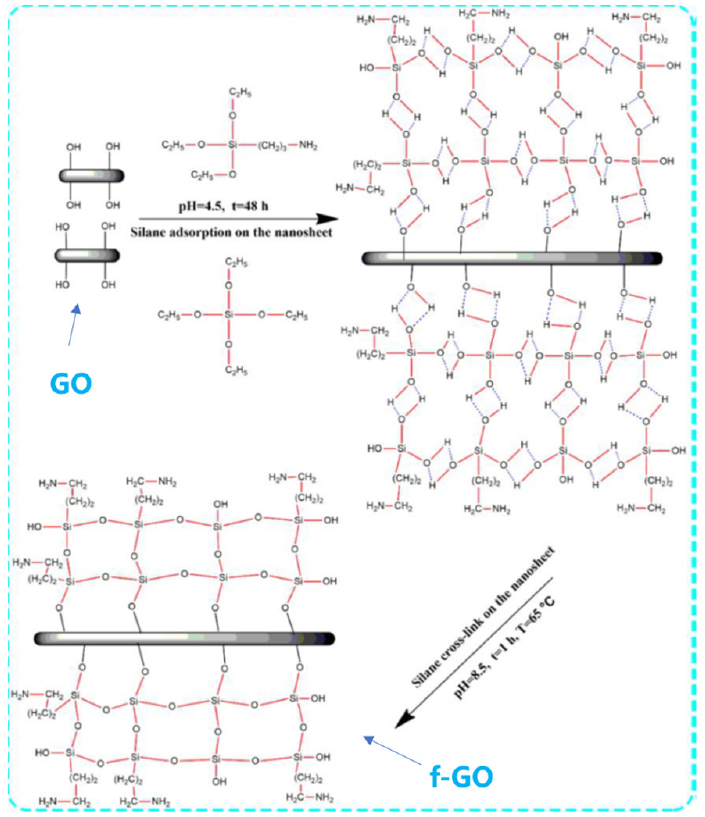
Figure 1. A synthesis diagram of functionalized GO nanosheets.